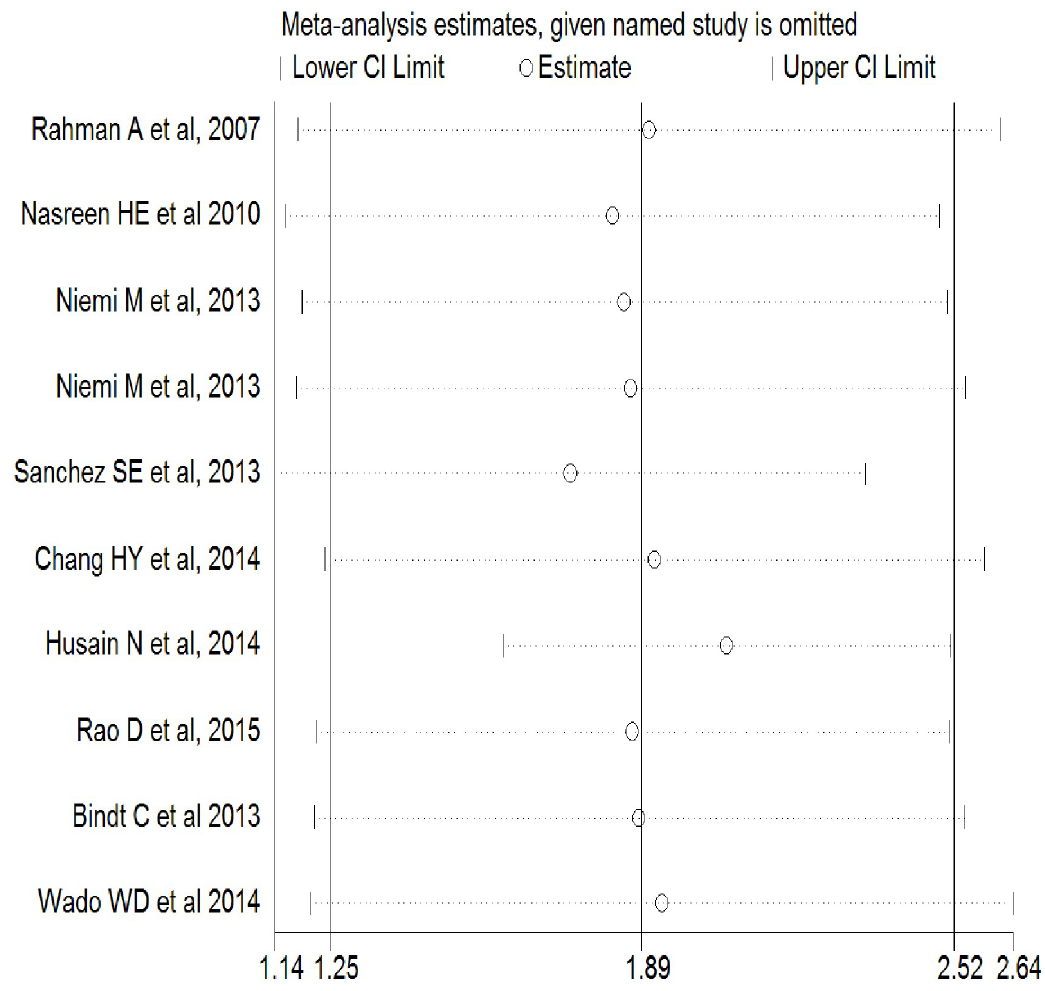
Fig 5. Sensitivity analysis for studies on antenatal depression and its effect on adverse birth outcomes (N = 9, 2007–2017).